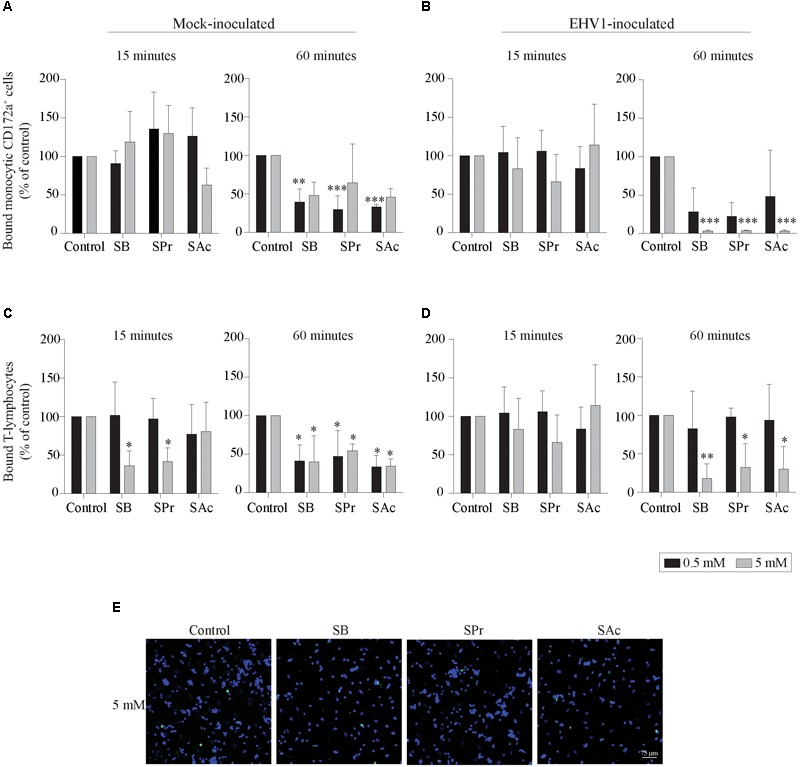
Short-chain fatty acid reduces the adhesion of mock- or EHV1-inoculated mononuclear cells to the target endothelium. (A,B) Monocytic cells or (C,D) T-lymphocytes were co-cultured during 15 (left panel) or 60 min (right panel) with 0, 0.5 or 5 mM SB, SPr, or SAc equine EC. Adherent mononuclear cells were counted per 100 EC in 5 ad random chosen fields. Viral proteins were stained in green (FITC). (E) Representative confocal images of the binding of EHV1-inoculated mononuclear cells to the target endothelium, pretreated with SCFA. Three independent experiments were performed and data are represented as means + SD. Statistical significant differences are shown with asterisks: ∗
p < 0.05; ∗∗
p < 0.01; ∗∗∗
p < 0.001; ns indicates p > 0.05.